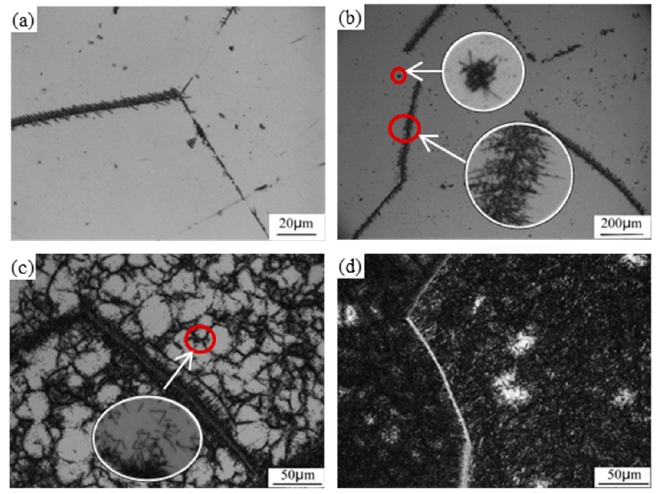
Figure 5. Microstructural developments during furnace cooling from 950 °C to ( a ) 640 °C; ( b ) 600 °C; ( c )580 °C; ( d ) Room temperature.